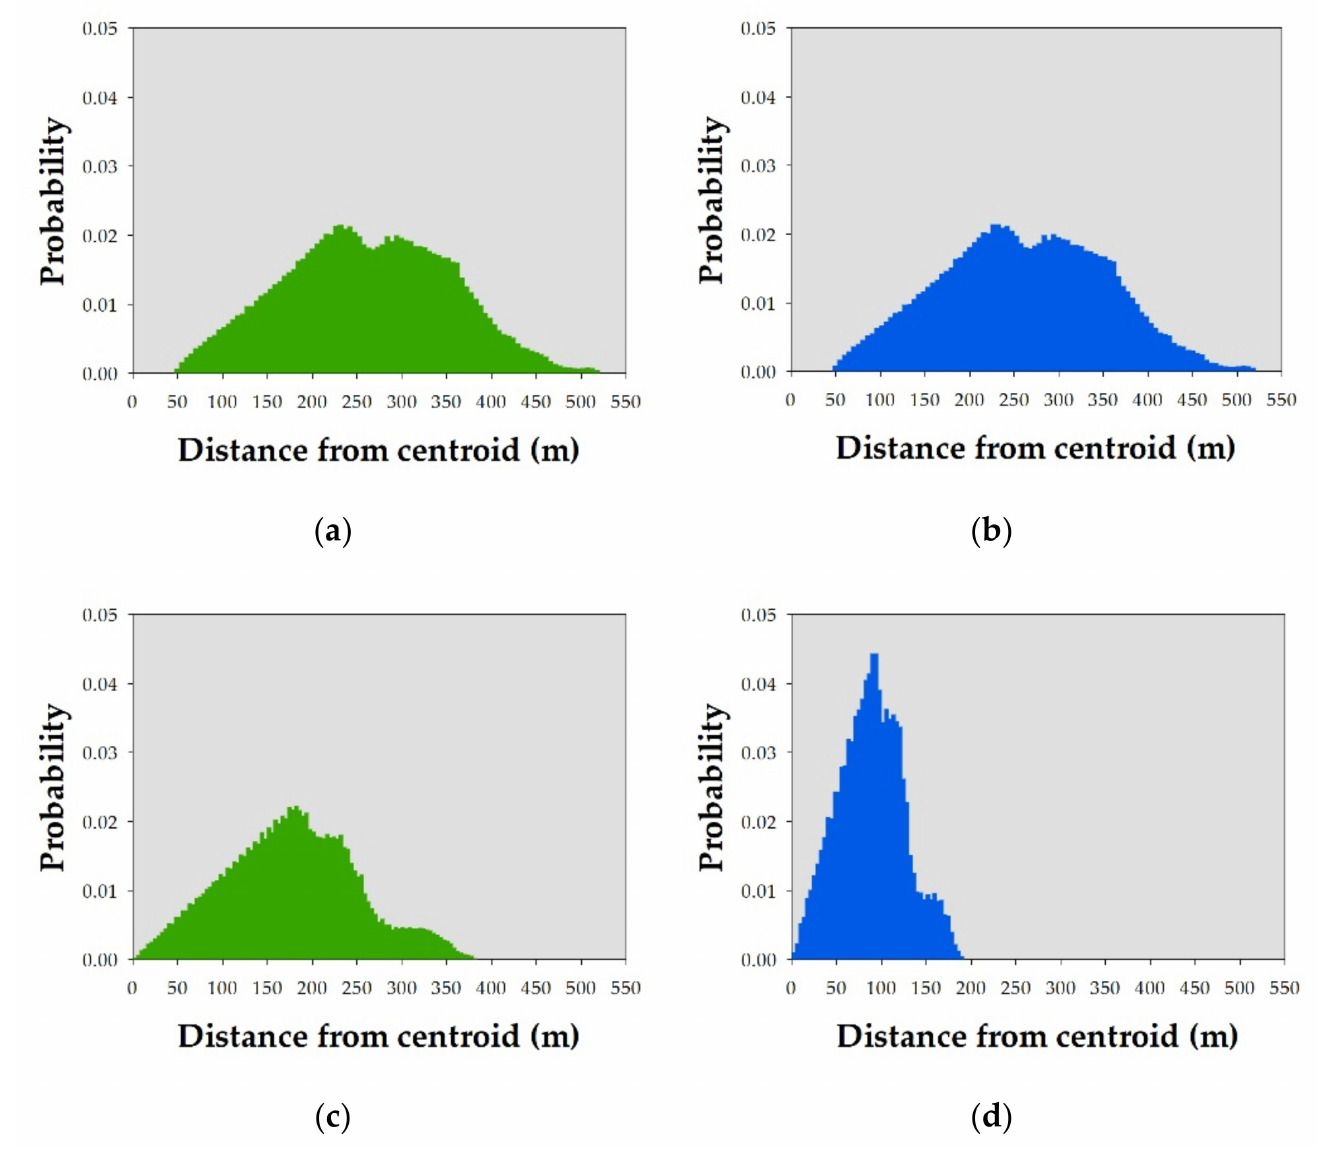
Figure 10. PDFs of distance from the centroid to each point ( δ ) for each pair of hypothetical patterns shown in Figure 5: ( a , b ) pair of eagle patterns and ( c , d ) pair of turtle